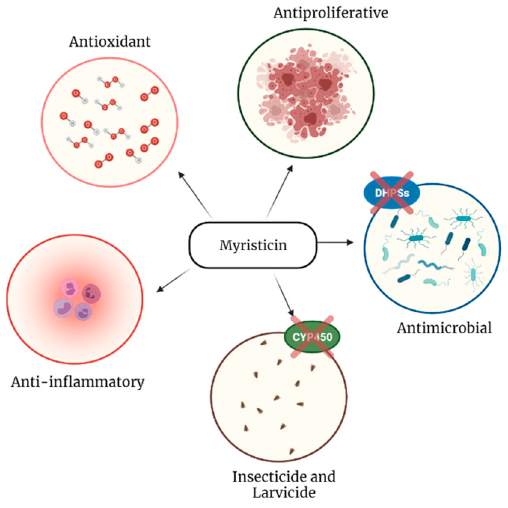
Figure 3. Graphical representation of the main biological activities of